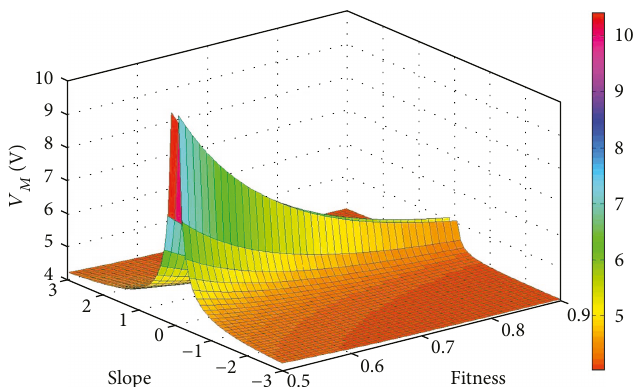
fi tness F , and slope S in the mutation process. M ,